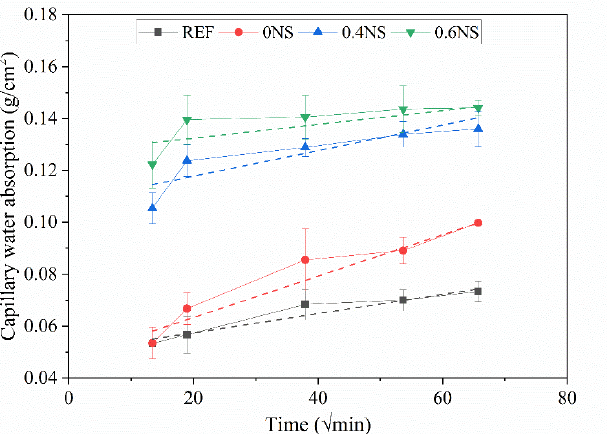
Figure 11. Capillary water absorption of mortars produced with RFA and replacement of Portland cement by NS, at 28 days. Dash lines represents the linear